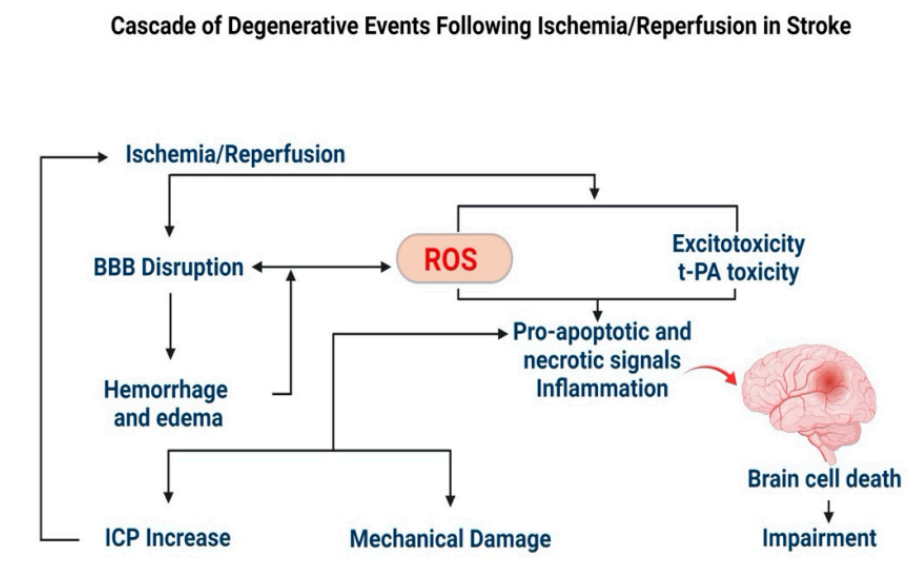
Figure 2. ROS-mediated degenerative events during a stroke. Excessive production of ROS during I/R injury leads to mechanical damage to the brain due to breakdown of the BBB, hemorrhage and edema, causing a build-up of intracranial pressure (ICP). The biochemical changes lead to inflammation and progression of apoptosis. Therefore, excess ROS formed during I/R is considered a target to inhibit the progression of secondary brain